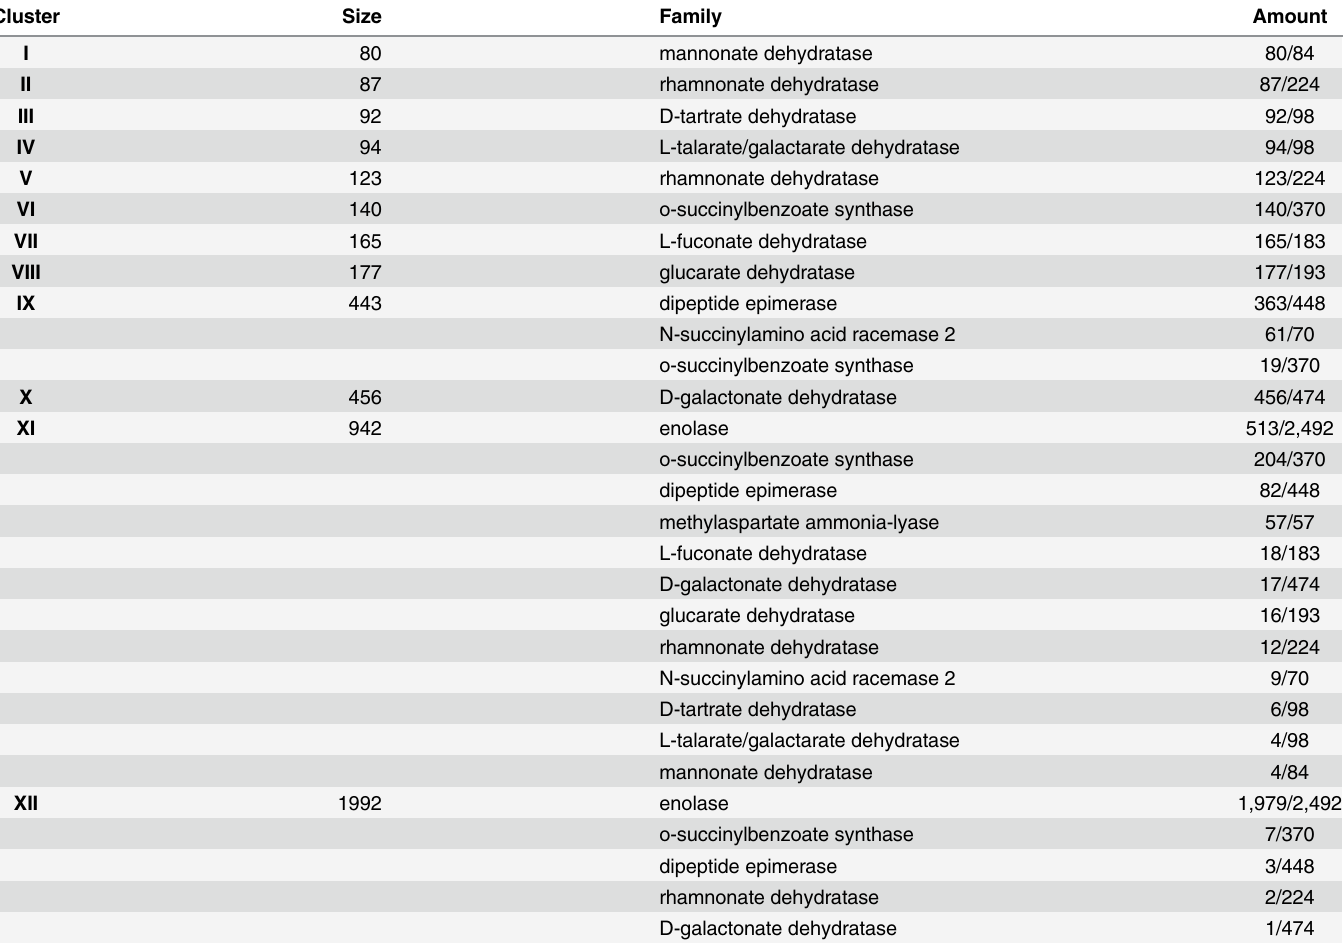
Table 14. Distribution of families among the twelve enolase superfamily clusters produced by the GP system. Cluster